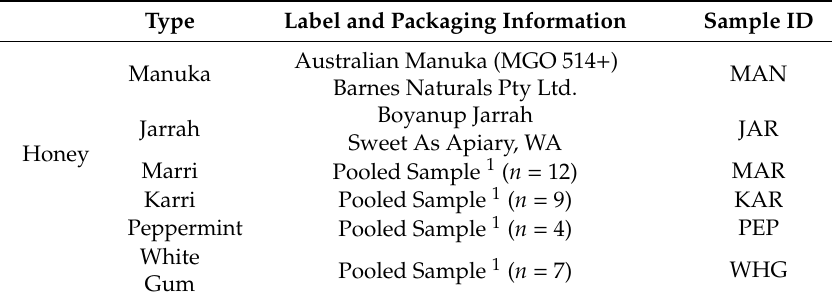
Table 4. Honey samples and commercial syrups.